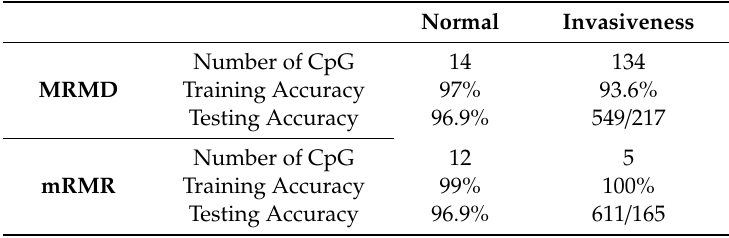
Table 1. The number of selected CpG sites and the performance of four classifiers for DNA methylation